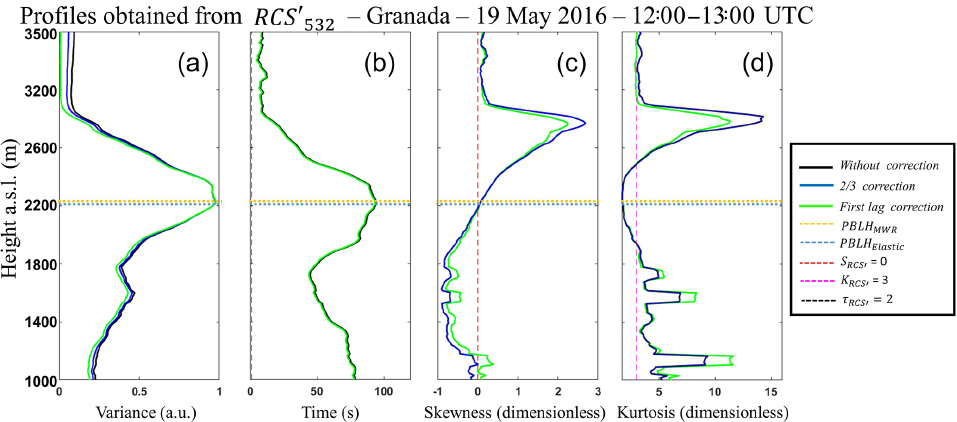
Figure 9. (a) Vertical profile of variance ( σ 2 (d) Vertical profile of kurtosis ( K RCS (cid:48) ). All profiles were obtained from MULHACÉN elastic lidar data on 19 May 2016 in Granada from